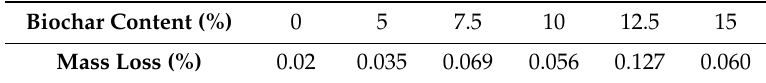
Table 3. Mass loss of asphalt binder after aging.